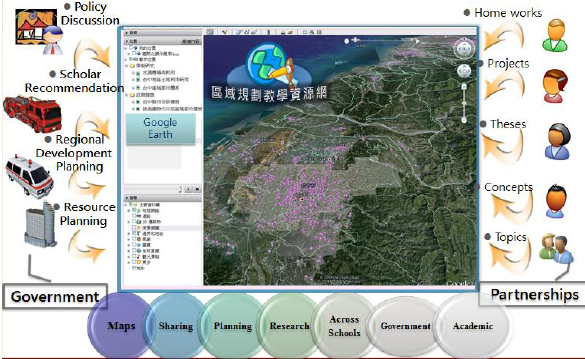
Figure 6 Regional Planning and Education Resources